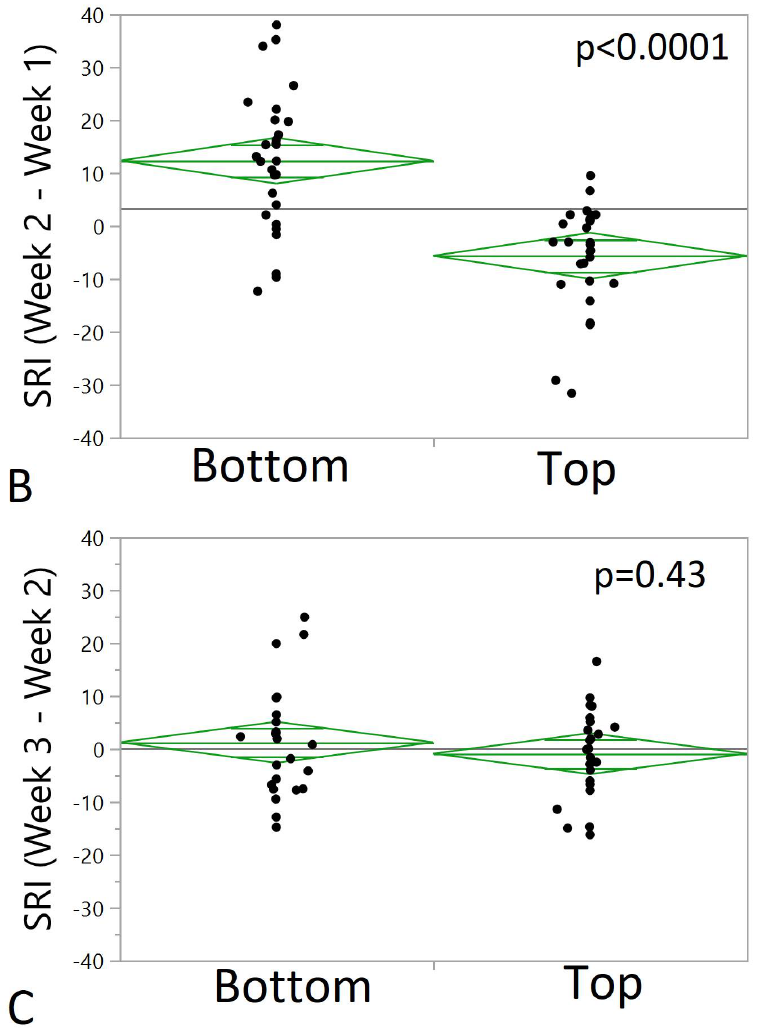
Figure 2. One-way plot between weekly SRI di ff erences (Week 3–Week 1, Week 2–Week 1, Week 3–Week 2) between top and bottom baseline SRI quartiles. Green diamonds represent confidence intervals. The center line represents the group mean. The vertical span of each diamond represents the 95% confidence interval for the mean of each group. ( A ) SRI di ff erences between week 3 and week 1 (y-axis) versus top and bottom baseline SRI quartiles (x-axis). One-way ANOVA shows a significant di ff erence in SRI (Week 3–Week 1) between top and bottom SRI participants ( p < 0.0001, N = 24). Change of SRI between week 3 and week 1 is significantly higher in the bottom 25% as compared to the top 25%. ( B ) SRI di ff erences between week 2 and week 1 (y-axis) versus top and bottom baseline SRI quartiles (x-axis). One-way ANOVA shows a significant di ff erence in SRI (Week 2–Week 1) between top and bottom SRI participants ( p < 0.0001, N = 24). Change of SRI between week 2 and week 1 is significantly higher in the bottom 25% as compared to the top 25%. ( C ) SRI di ff erences between week 3 and week 2 (y-axis) versus top and bottom baseline SRI quartiles (x-axis). One-way ANOVA shows no significant di ff erence in SRI (Week 3–Week 2) between top and bottom baseline SRI quartiles ( p = 0.43, N =